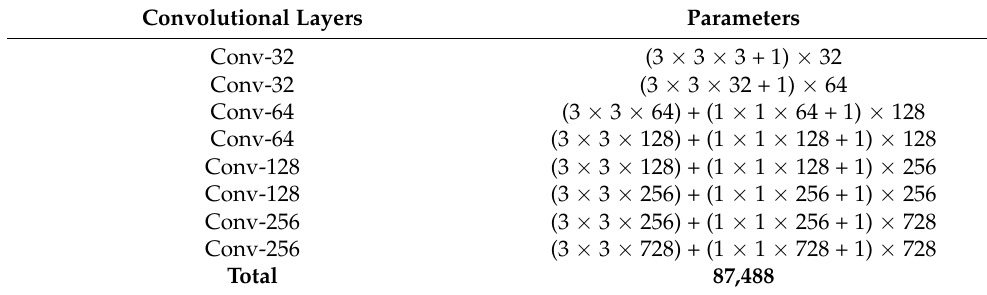
Table 4. Parametric configuration of the convolutional layer of proposed CAD-HR model.